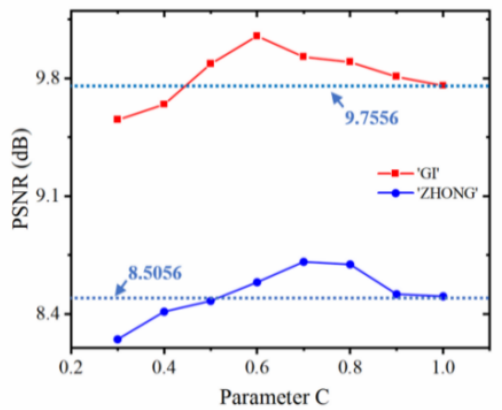
Figure 4. Peak Signal-to-Noise Ratio (PSNR) curves vs. C of the reconstruction result of “GI” and “ZHONG”. The upper and lower dotted lines represent the PSNR values of reconstruction results when the number of data groups was 5000.